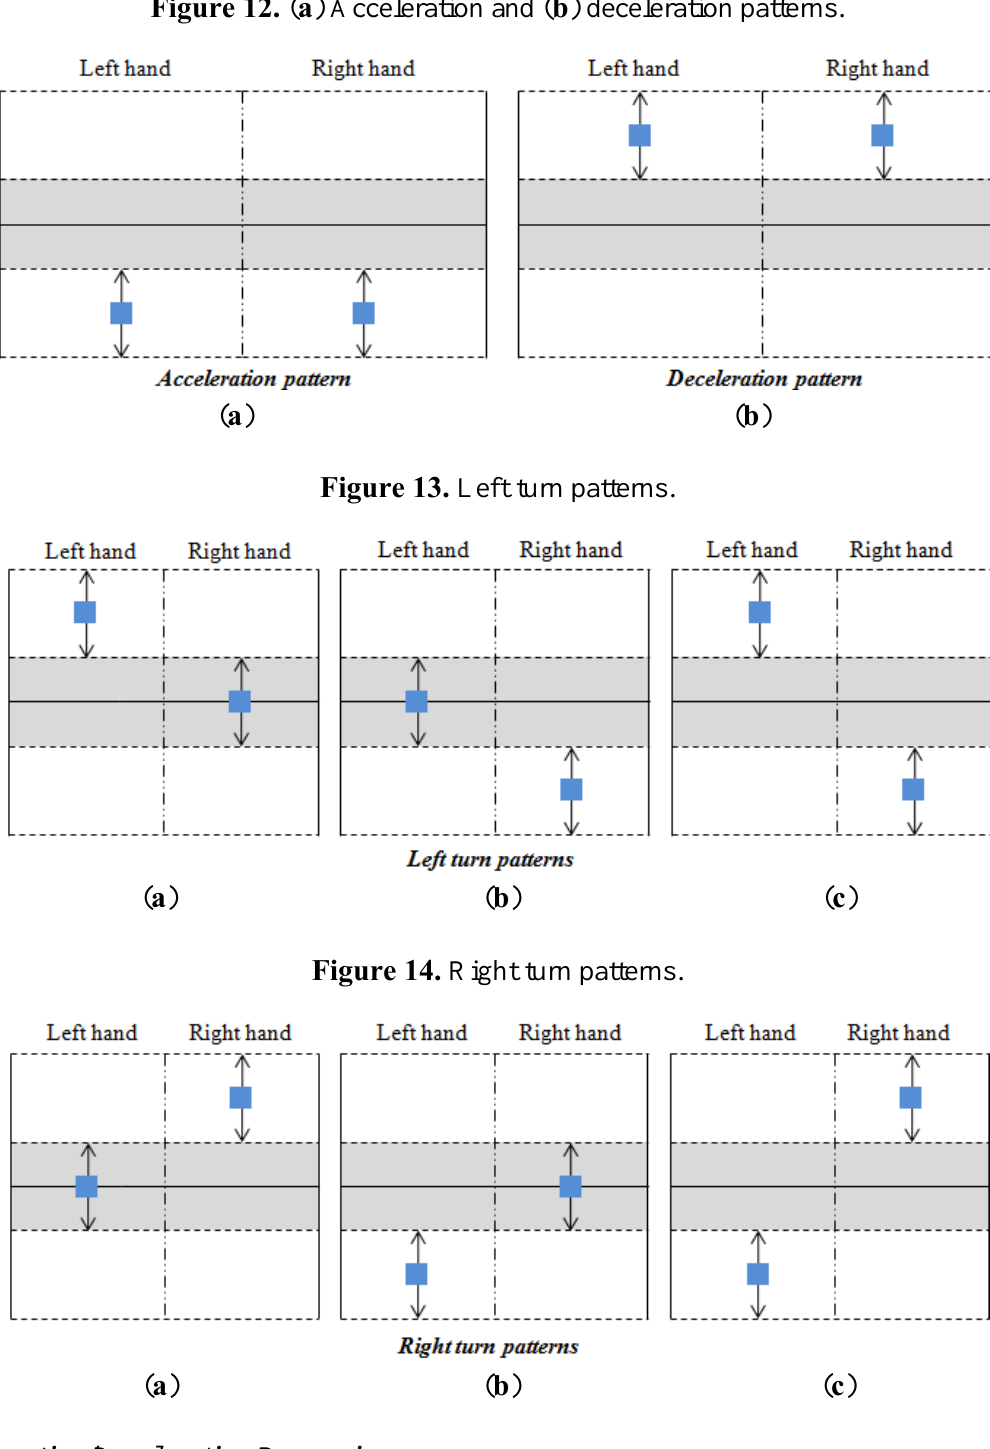
Figure 12. ( a ) Acceleration and ( b ) deceleration patterns.